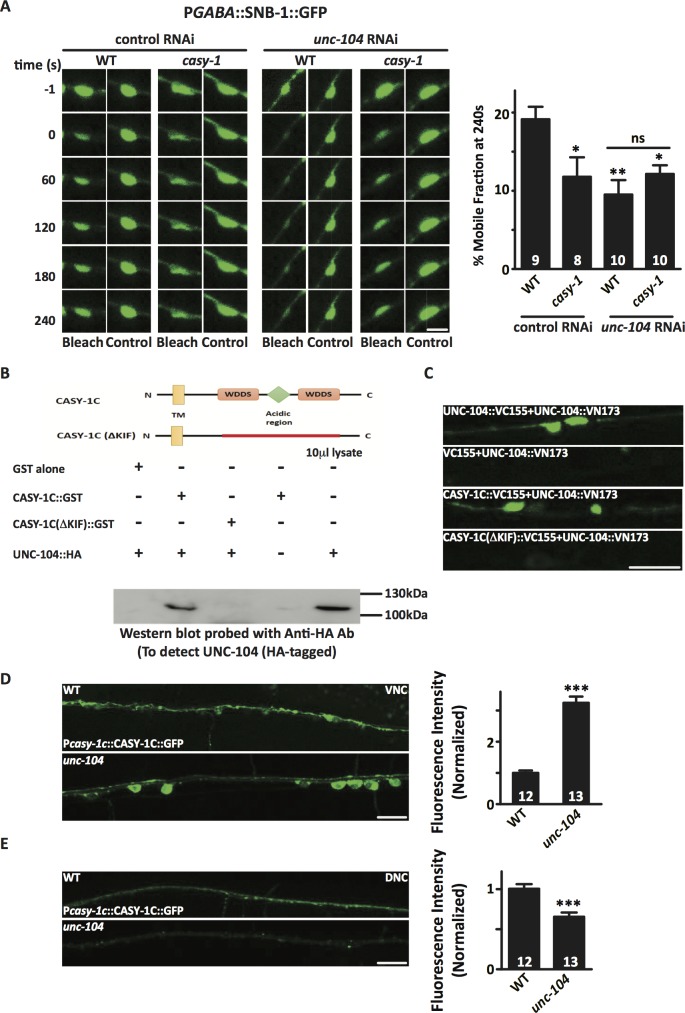
CASY-1 interacts with the kinesin motor UNC-104/KIF1A to regulate the trafficking of GABA vesicles.(A) FRAP analysis of SNB-1::GFP levels in GABAergic motor neurons reveals that the dynamics of SV mobility is reduced after unc-104 RNAi. Representative confocal images of pGABAergic::SNB-1::GFP levels compared between WT, casy-1 mutant, unc-104 RNAi and casy-1; unc-104 RNAi shows images before photo-bleaching (pre-bleach), immediately after photo-bleaching (post-bleach) and 240 sec after photo-bleaching (recovery). Scale bar, 2μm. The fractional recovery of fluorescence 240 sec after photo-bleaching is shown. (B) The upper panel shows the domain organization of CASY-1C illustrating the two conserved WDDS motifs surrounding an acidic region containing stretches of glutamic acid residues. The CASY-1C (ΔKIF) represents a deletion in the region harboring the two WDDS motifs and the acidic region (amino acids 70–148) in the C- terminal region of CASY-1C. The lower panel shows a GST pull down assay showing that CASY-1 C-terminal can interact with the tail region of UNC-104. HA-tagged UNC-104 expressed in bacterial cell extract was incubated with bead-bound GST fusion proteins CASY-1C GST and CASY-1C (ΔKIF) GST. The blot was probed with anti-HA antibody. Significant pull down of 110 KDa HA-tagged UNC-104 was observed with CASY-1C GST. A deletion in the KIF-binding domain in CASY-1C eliminates the pull down of HA-tagged UNC-104 from the bacterial lysate. 10 μl of bacterial cell lysate was loaded as control. (C) Representative fluorescence micrographs summarizing the results of BiFC assay. BiFC signals from UNC-104 VN and UNC-104 VC interactions along the VNC (positive control). No BiFC signals were observed from UNC-104 VN and Empty VC (negative control). BiFC signals of UNC-104 VN and CASY-1C VC interactions observed in the GABA ventral cord motor neurons. Intensity of BiFC signals were significantly reduced in UNC-104 VN and CASY-1C (ΔKIF) VC BiFC pair. Scale bar, 10μm. (D) Intracellular localization of Pcasy-1c::CASY-1C::GFP in VNC cell bodies in unc-104 mutant background. In this mutant background, CASY-1C::GFP is significantly sequestered in cell bodies compared to WT control animals. A circular ROI was quantified in each image for two cell bodies and then averaged for each image intensity values. (E) In parallel, the fluorescence intensity of CASY-1C::GFP was significantly decreased at the DNC synapses in unc-104 mutants. Quantification of fluorescent intensity is normalized to WT values. The number of animals analyzed for each genotype is indicated at the base of the bar graph. Quantified data are displayed as mean ± S.E.M. and were analyzed by two-tailed Student’s t-test. Scale bar, 10μm.